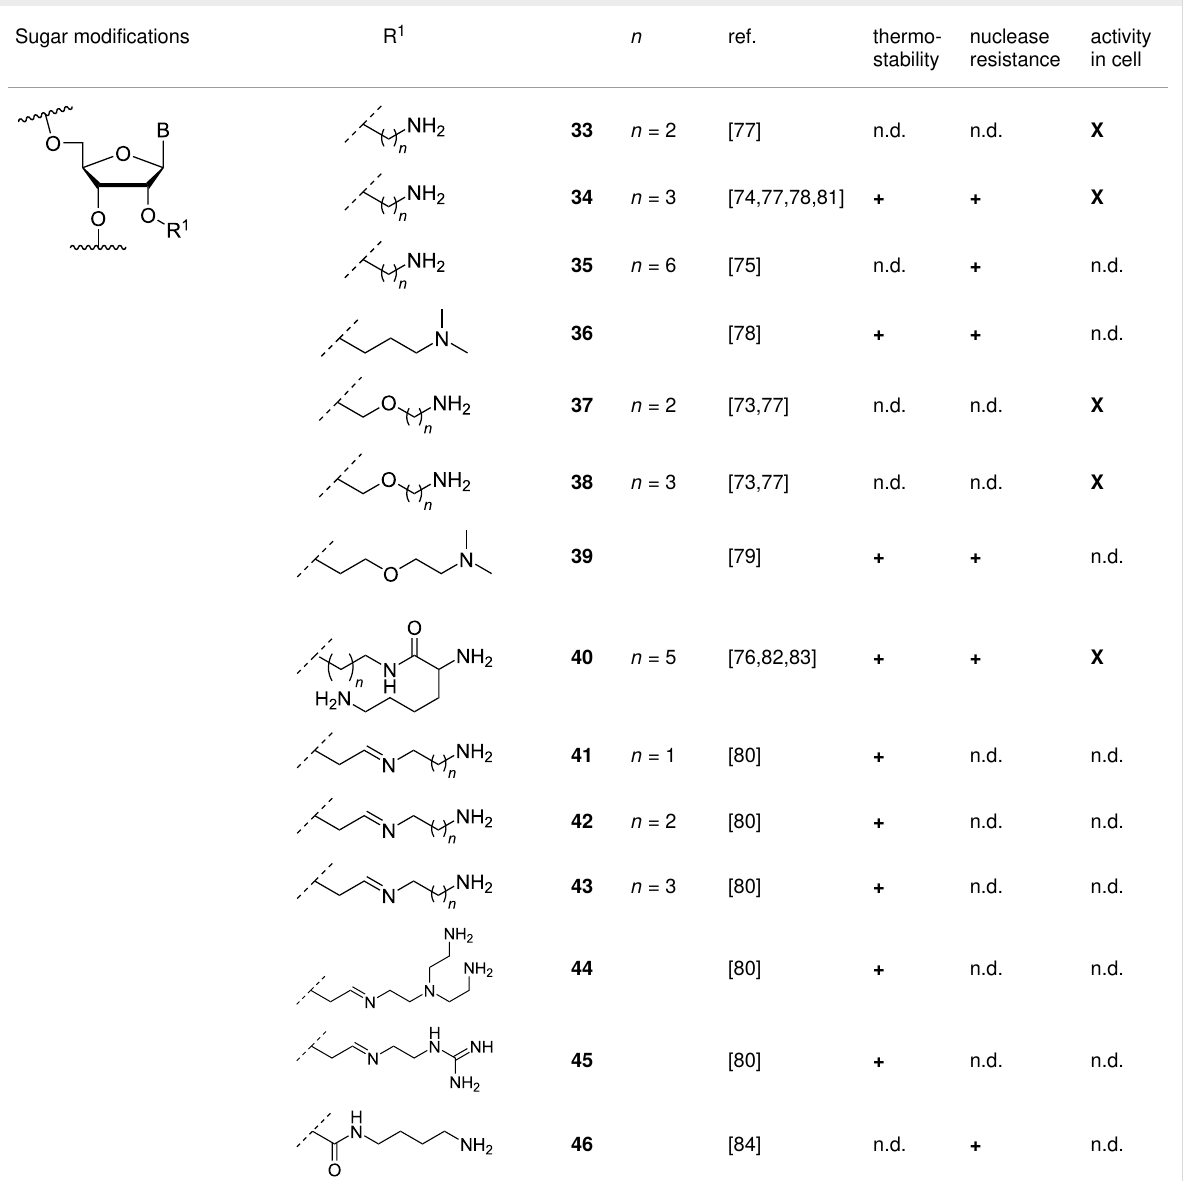
Table 4: Amine-functionalized groups attached to the sugar scaffold.